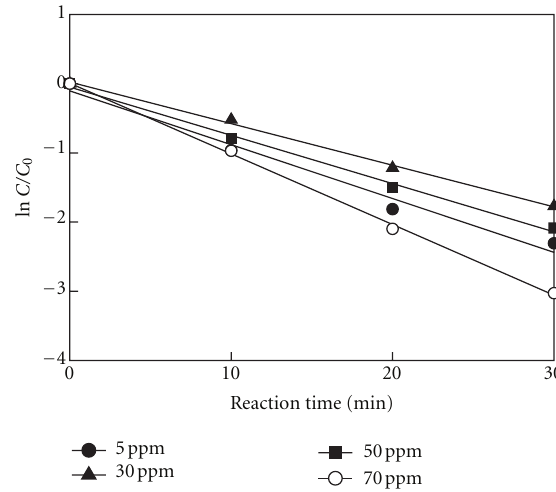
Figure 3: E ff ect of TiO 2 particle dosages for decomposition of methylene blue in aqueous solutions.